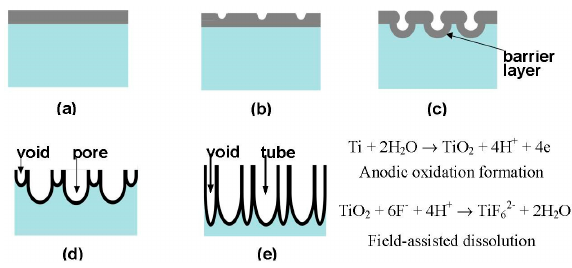
Figure 9. Schematic diagram of the TiO 2 NT growth mechanism. ( a ) Growth of dense and thin oxidation layer; ( b ) formation of pores onto the layer; ( c ) growth of the pores and repassivation of the pore tips; ( d ) growth of voids in the metallic part between pores under oxidation and chemical dissolution; and ( e ) the growth of fully developed TiO 2 NT arrays. Reprinted with permission from [38]. Copyright 2012 The University of New South Wales.